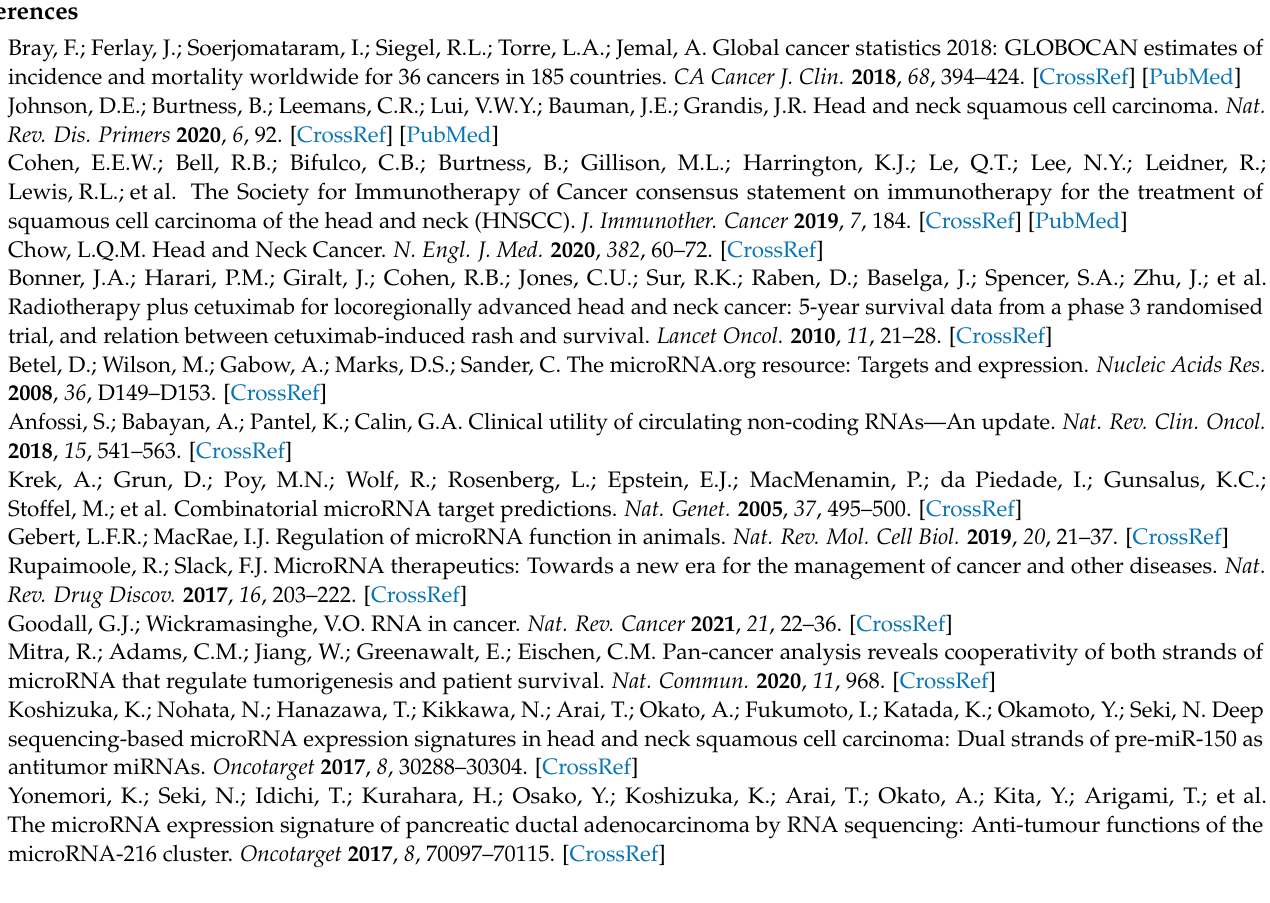
assays. Figure S2: Efficiency of siRNA mediated FOXD1 knockdown in HNSCC cell lines (Sa3 and SAS cells). Figure S3: Photomicrographs of cells subjected to migration and invasion assays. Table S1: Clinical features of the patient in GSE180077. Table S2: Used reagents in this study. Table S3: Clinical features of HNSCC patients for